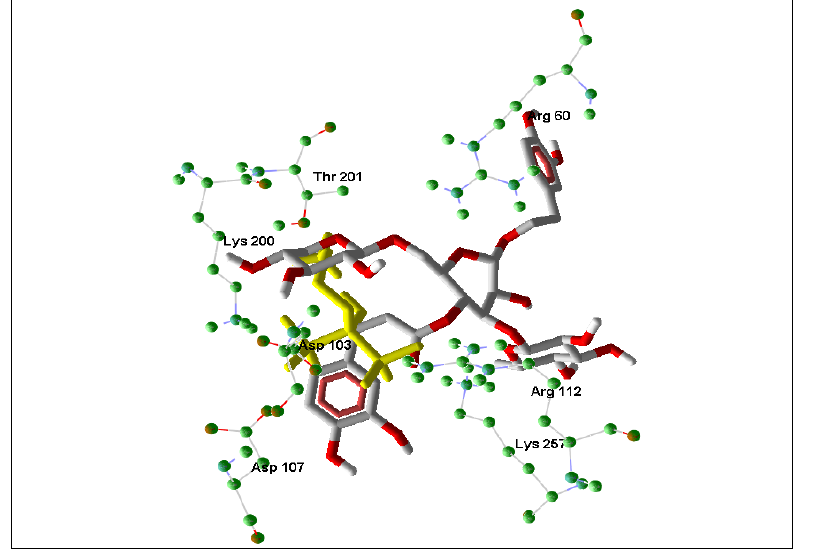
Figure 3. Top pose of angoroside C (white and red) and the co-crystallized ligand; alendronate (yellow) in the binding site of Human FDS, illustrating the orientation of important binding site residues Lys 257, Arg 112, Asp 107, Asp 103, Lys 200 around the phenolic